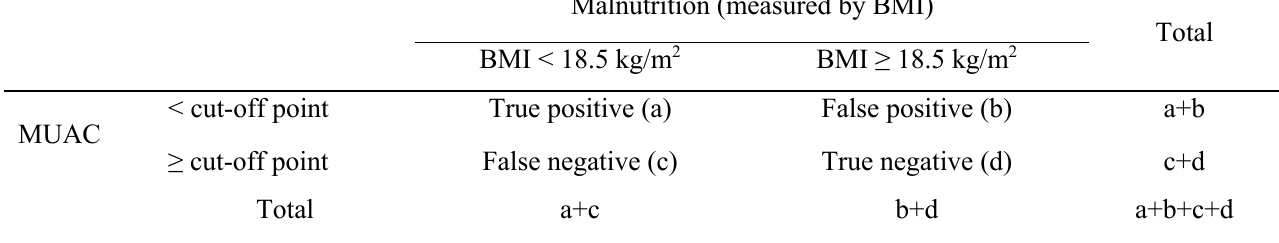
Table 1 . 2x2 table for MUAC and